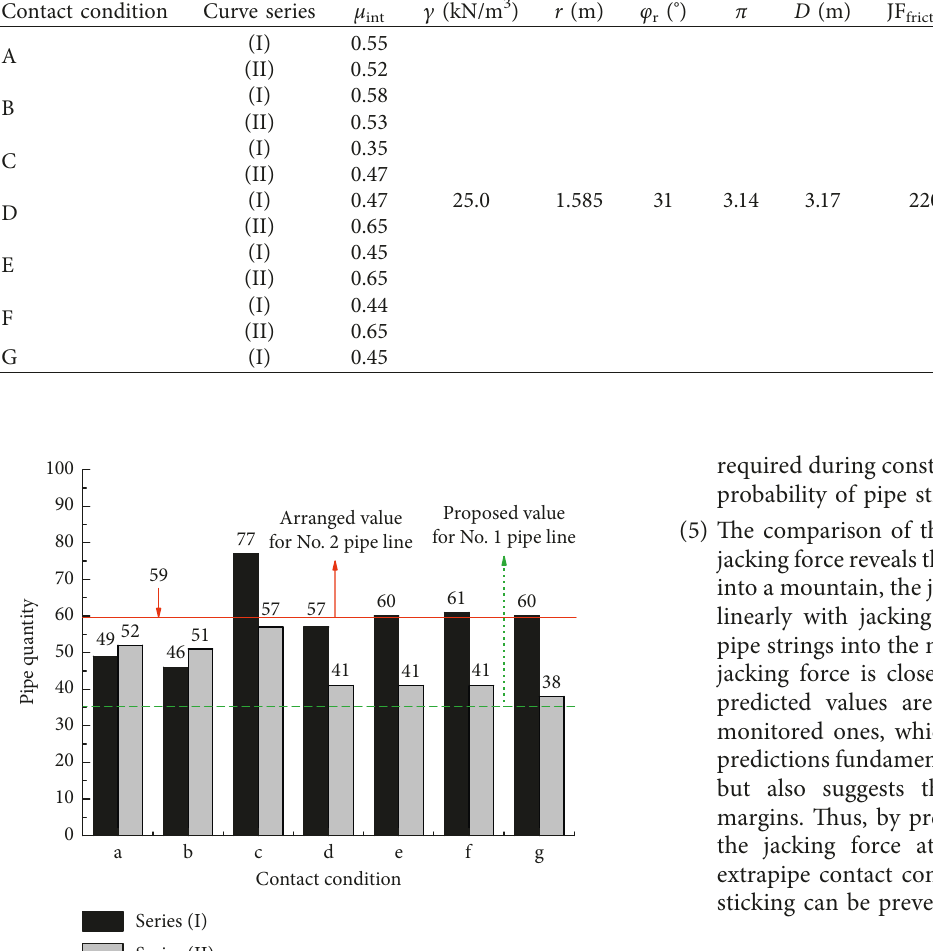
Table 4: Prediction of the maximum number of pipes driven by adjacent IJSs under different contact conditions. Contact condition Curve